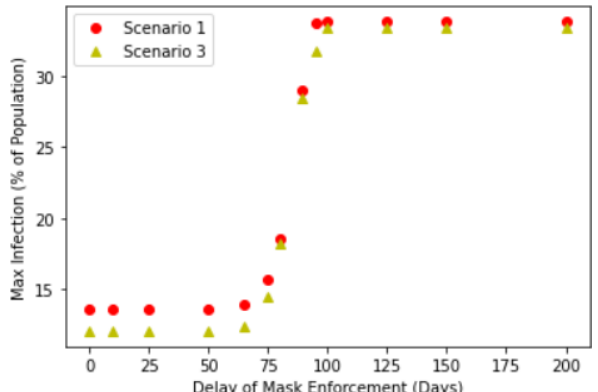
Figure 6. Maximum infection against delay in mask enforcement for Scenario 2: SEIR with full compliance and Scenario 3: SEIRS with time-limited immunity for the B117 variant case.